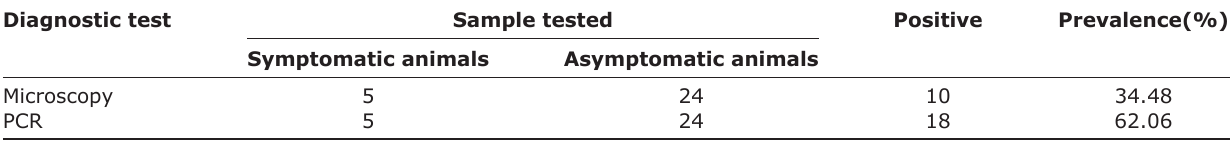
Table-1: Comparison of microscopy and PCR assay for detection of T.annulata in terms of prevalence. Diagnostic test